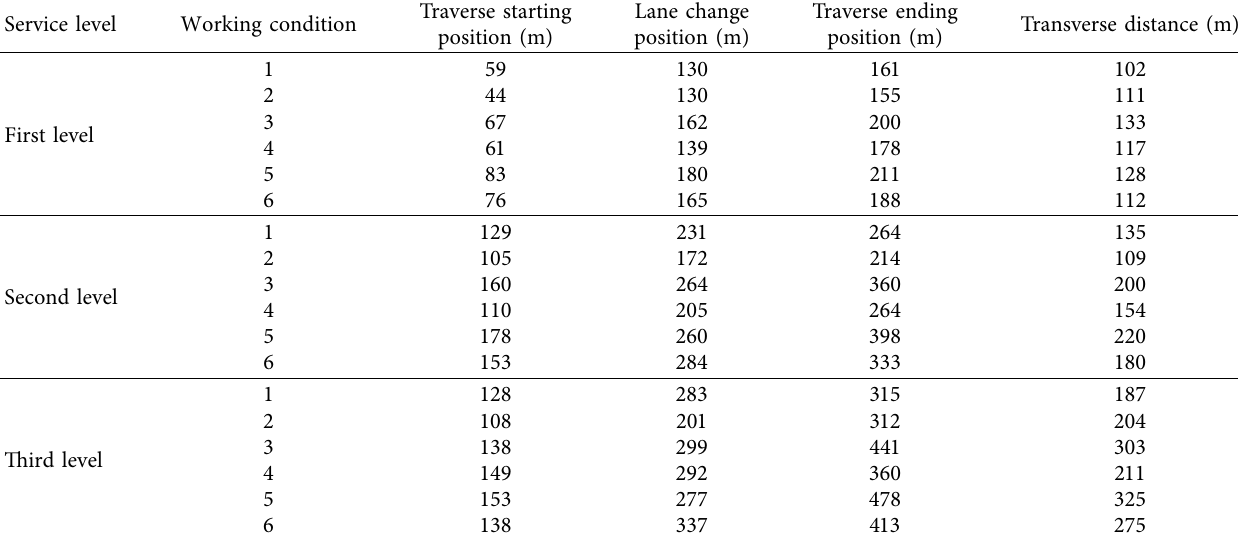
Table 3: Vehicle traverse